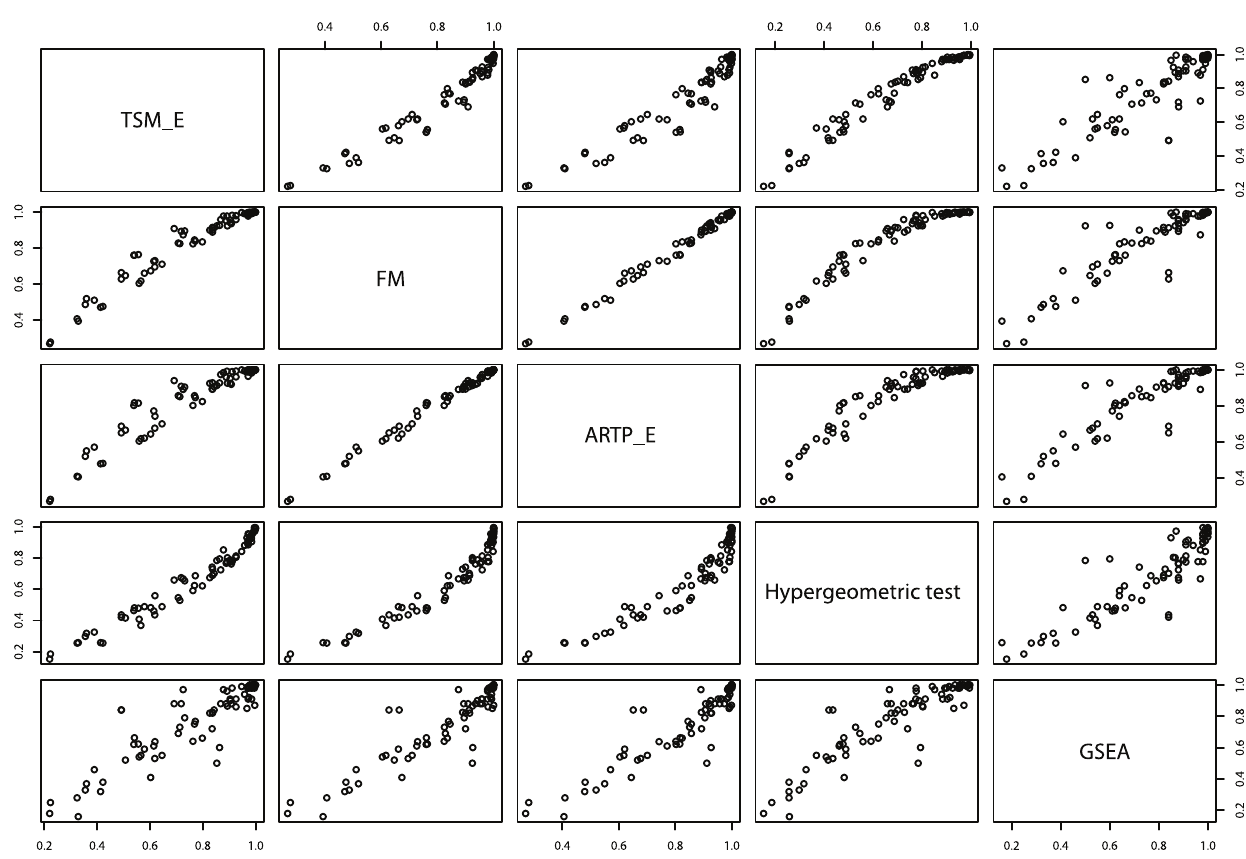
Figure 3. Pairwise scatterplot of power for the five methods across all simulated non-null scenarios.